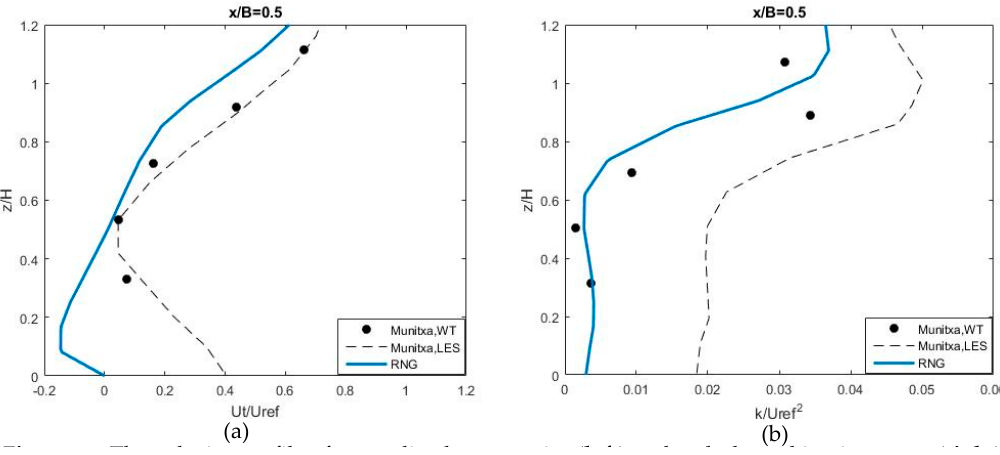
Figure 28. The velocity profile of normalized streamwise ( left ) and turbulence kinetic energy ( right ) at the center of canyon.